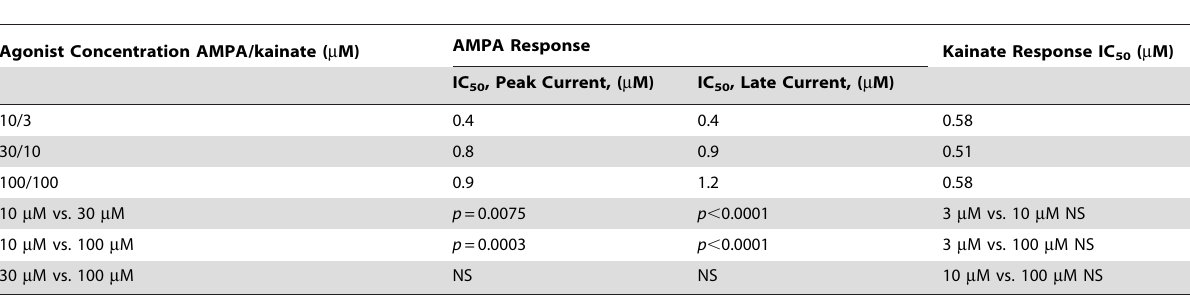
Table 1. IC 50 Values for Perampanel Inhibition of AMPA- and Kainate-Evoked Currents.